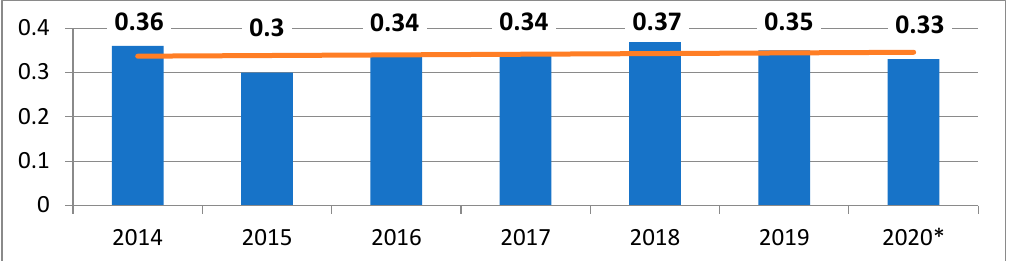
Figure 1. Energy usage of GDP (tons of oil equivalent per thousand U.S. dollars in 2015 prices). * Preliminary data. The orange line is the average value for the period 2014–2020.